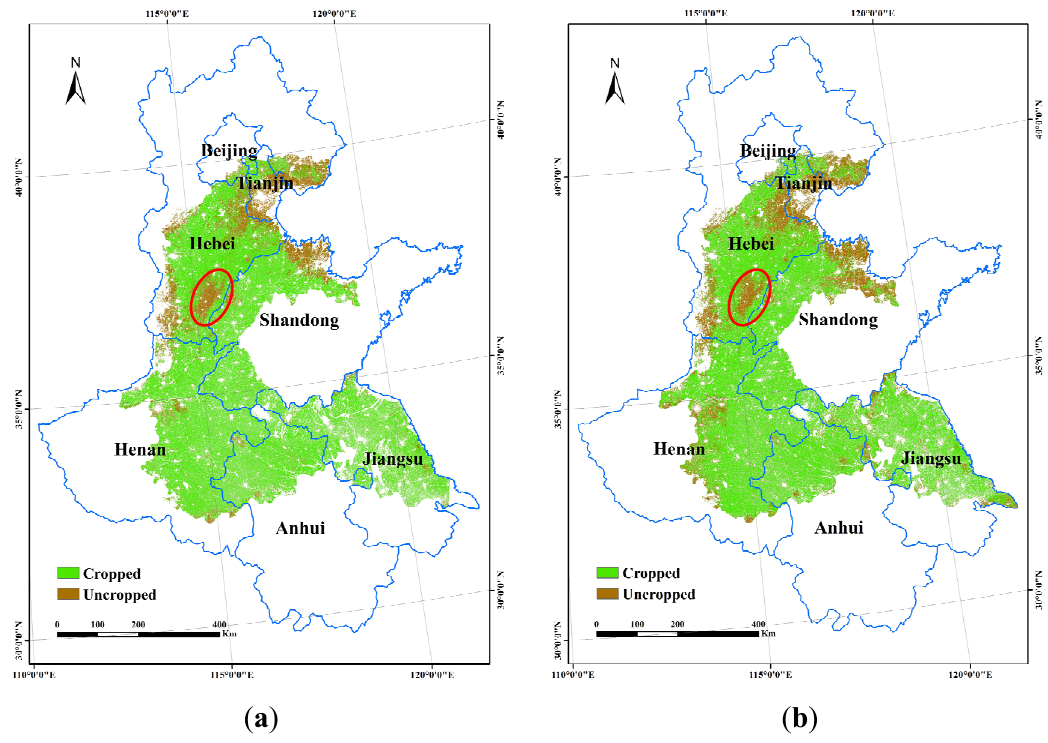
Figure 4. The distribution of cropped and uncropped arable land for the winter